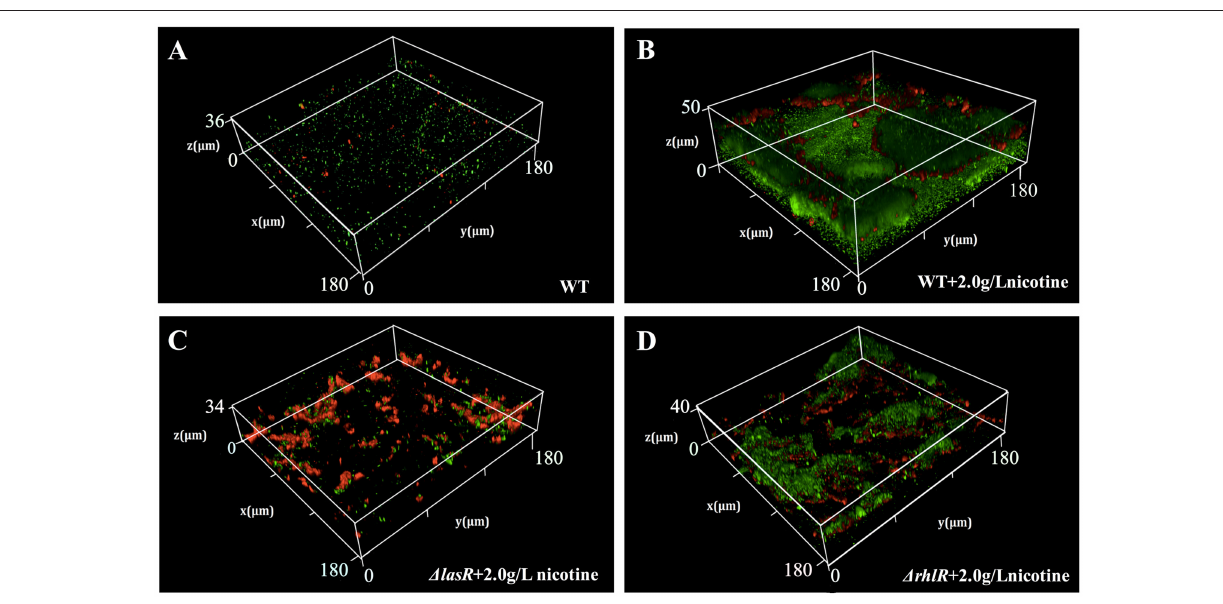
positive control, it was observed that the level of ROS produced by 2.0 g/L-nicotine treatment, is higher than that produced by 2 mM-H 2 O 2 treatment. Therefore, it can be inferred that the